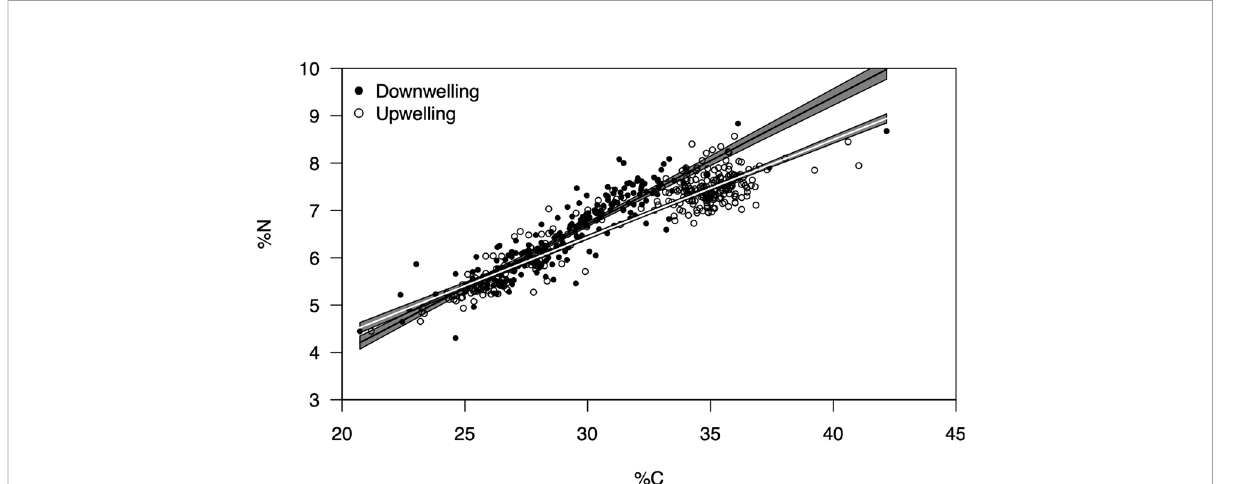
FIGURE 4 Relationship between % C and % N for Carcinus maenas megalopae collected during downwelling ( n = 226) and upwelling ( n = 307). The slopes of the predicted linear regressions (thick lines) represent the C:N ratio for the megalopae during the two contrasting supply events (black for downwelling, white for upwelling). The grey area depict the con fi dence intervals (2 times the St. Error). The C:N ratios were signi fi cantly different between supply events (two-tailed Students ’ t-test, p <